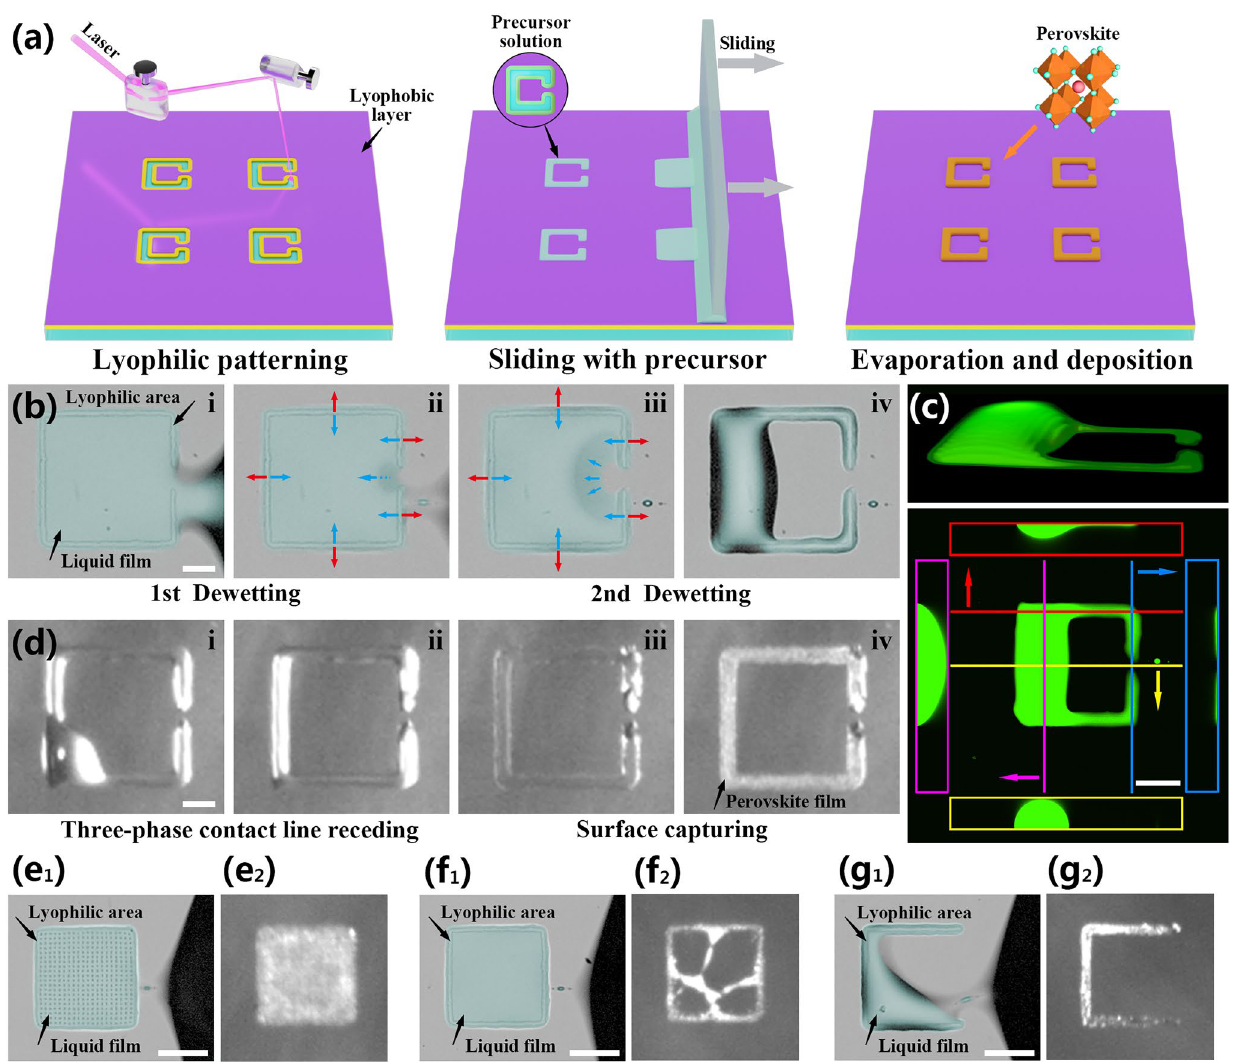
Fig. 2 a Schematic diagram of the preparation process of the photodetector array based on the split-ring structured perovskite film. b The perovskite precursor solution dewetting processes captured by a high-speed camera (blue and red arrows indicate surface tension and pinning force, respectively, scale bar: 50 μm). c Themorphology of a glycerol split-ring droplet taken by Confocal microscope after dewetting process (scale bar: 80 μm). d The evaporation process of precursor solution captured by a high-speed camera on the hot plate (scale bar: 50 μm). e–g The dewetting and deposition results of a fully lyophilic square pattern, a square ring pattern without opening, the split-ring pattern, and a trilateral pattern (scale bar: 100